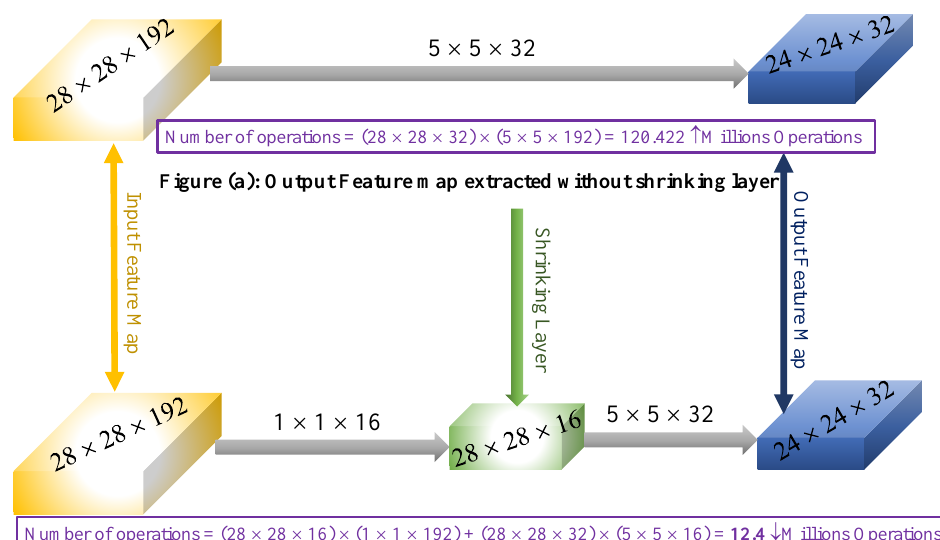
Number of operations = (28  28  32)  (5  5  192) = 120.422  Millions Operations Figure (a): Output Feature map extracted without shrinking layer